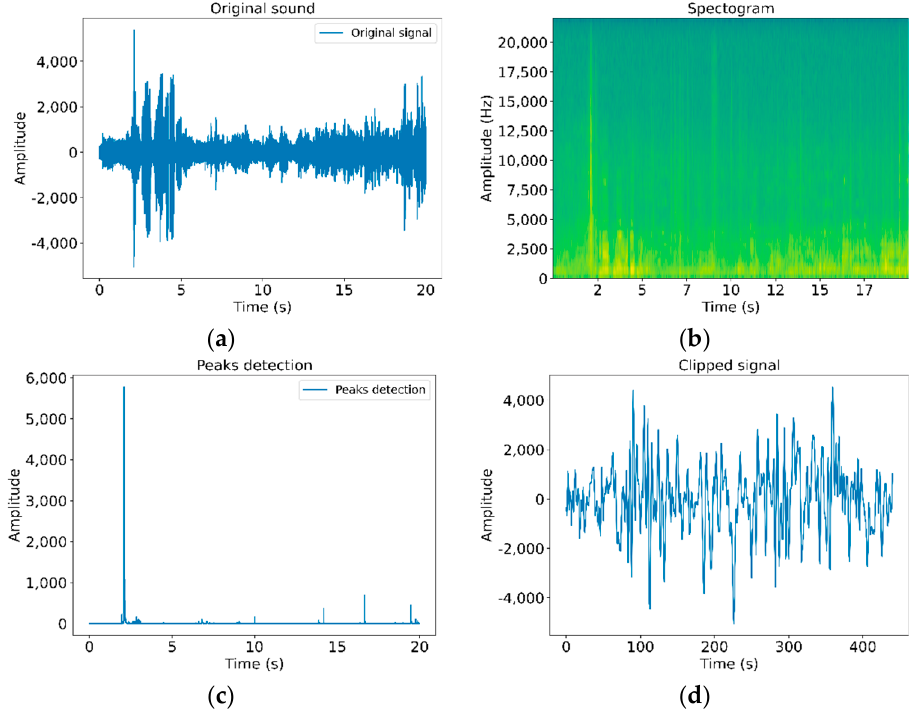
Figure 4. Signal processing: ( a ) original signal trimmed to 20 s, ( b ) spectrogram of the signal, ( c ) peaks detection, ( d ) signal window selected.